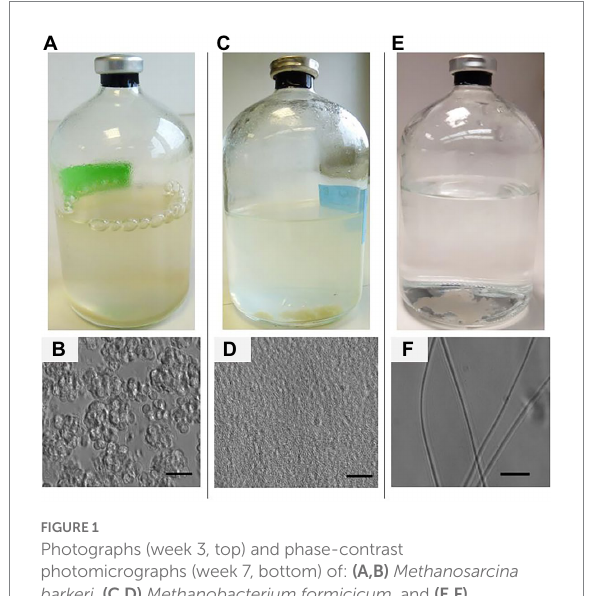
FIGURE 1 Photographs (week 3, top) and phase-contrast photomicrographs (week 7, bottom) of: (A,B) Methanosarcina barkeri , (C,D) Methanobacterium formicicum , and (E,F) Methanothrix soehngenii , grown in the BFS01 medium , bars indicate 10 μ